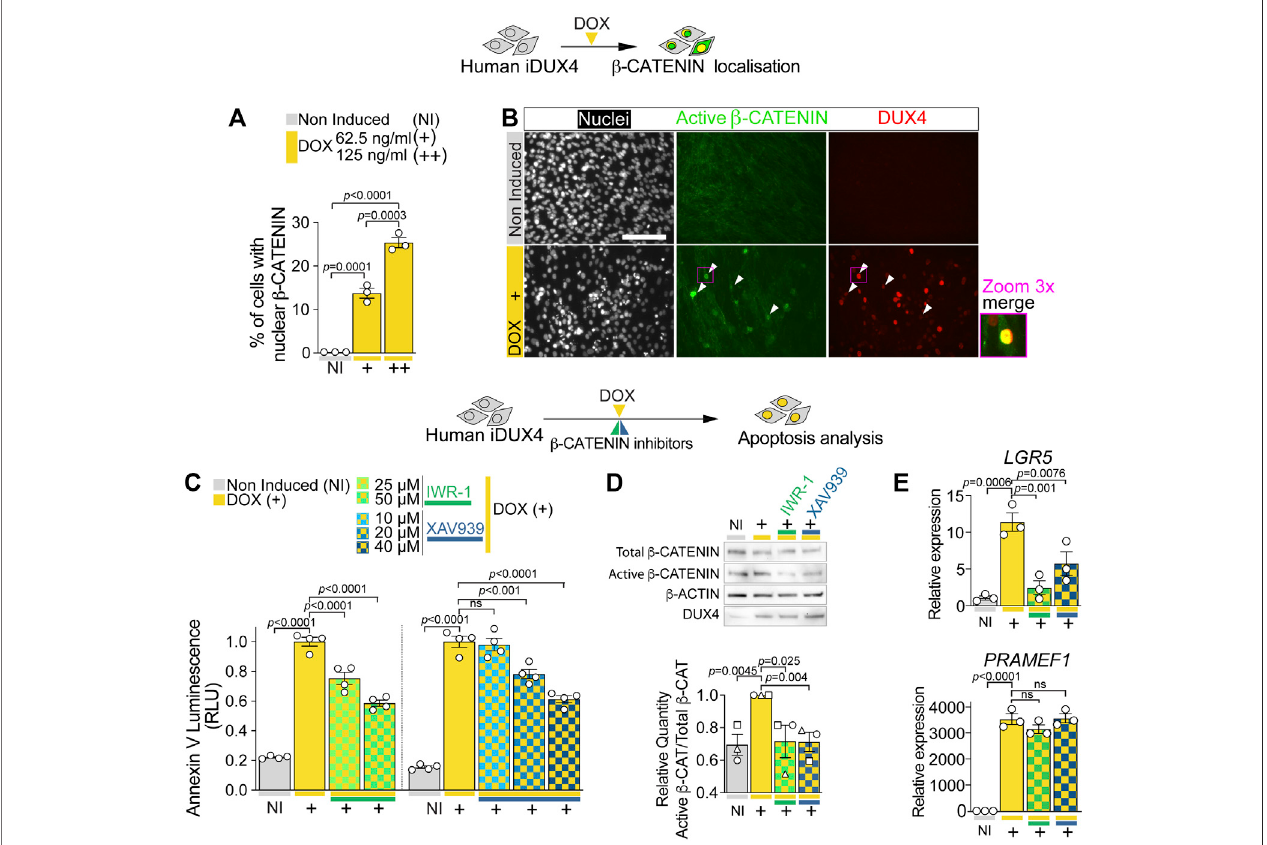
FIGURE4| DUX4increases β -CATENINnuclearshuttlingandactivity. (A) Quanti fi cationofthepercentageofiDUX4myoblastswithnuclear β -CATENINwhennon- induced (NI) or after treatment with either 62.5 (+) or 125 ng/ml (++) DOX for 24 h showing dose-dependent effect of DOX compared to non-induced control. N = 3biologicalreplicates,ANOVA, Tukey ’ sposthoctest. (B) Representativeimages ofproliferating non-induced iDUX4myoblastsand thoseinducedwith62.5 ng/mlDOX (+) for 24 h and immunolabelled for Active β -CATENIN (green) and DUX4 (red) with nuclei counterstained with DAPI (white) showing nuclear accumulation upon DUX4 induction. Arrowheads indicate Active β -CATENIN localisation in induced cells. Scale bar represents 100 µm. (C) Quanti fi cation of apoptosis in iDUX4 myoblasts whennon-induced (NI) orafter 62.5 ng/mlDOX(+)for 24 hshows robustapoptosisupon DOXtreatment, thatissigni fi cantly reducedwhen co-treated withindicated β - CATENIN inhibitors at shown concentration, compared to non-induced (NI) controls. Coloured lines beneath graphs indicate speci fi c inhibitors. N = 4 biological replicates, ANOVA, Tukey ’ s posthoc test. (D) Representative Western blot and quanti fi cation in proliferating non-induced iDUX4 myoblasts (NI) and those induced with either 62.5 ng/ml DOX (+) or 62.5 ng/ml DOX together with highest concentrations of indicated β -CATENIN inhibitors (IWR-1 50 µM and XAV939 40 µM). This reveals that increased Active β -CATENIN upon DUX4 induction is reduced by concomitant blockade of β -CATENIN activation, which does not affect DUX4 accumulation (quanti fi cationin SupplementaryFigureS5F ).N=3biologicalreplicates, ANOVA,Tukey ’ sposthoctest.RatioofTotal/Active β -CATENIN isreportedasfoldchangeto DOX-treated (+) samples. (E) RT-qPCR analysis on iDUX4 myoblasts treated as in D, showing effect of DUX4 induction and inhibition of β -CATENIN signalling on expression of LGR5 and the DUX4 target gene PRAMEF1 . N = 3 wells, ANOVA, Holm-Sidak ’ s posthoc test. Relative expression as fold change to NI iDUX4 sample is reported. Graphs report mean ± SEM with statistical signi fi cance between speci fi c samples indicated by a bar.